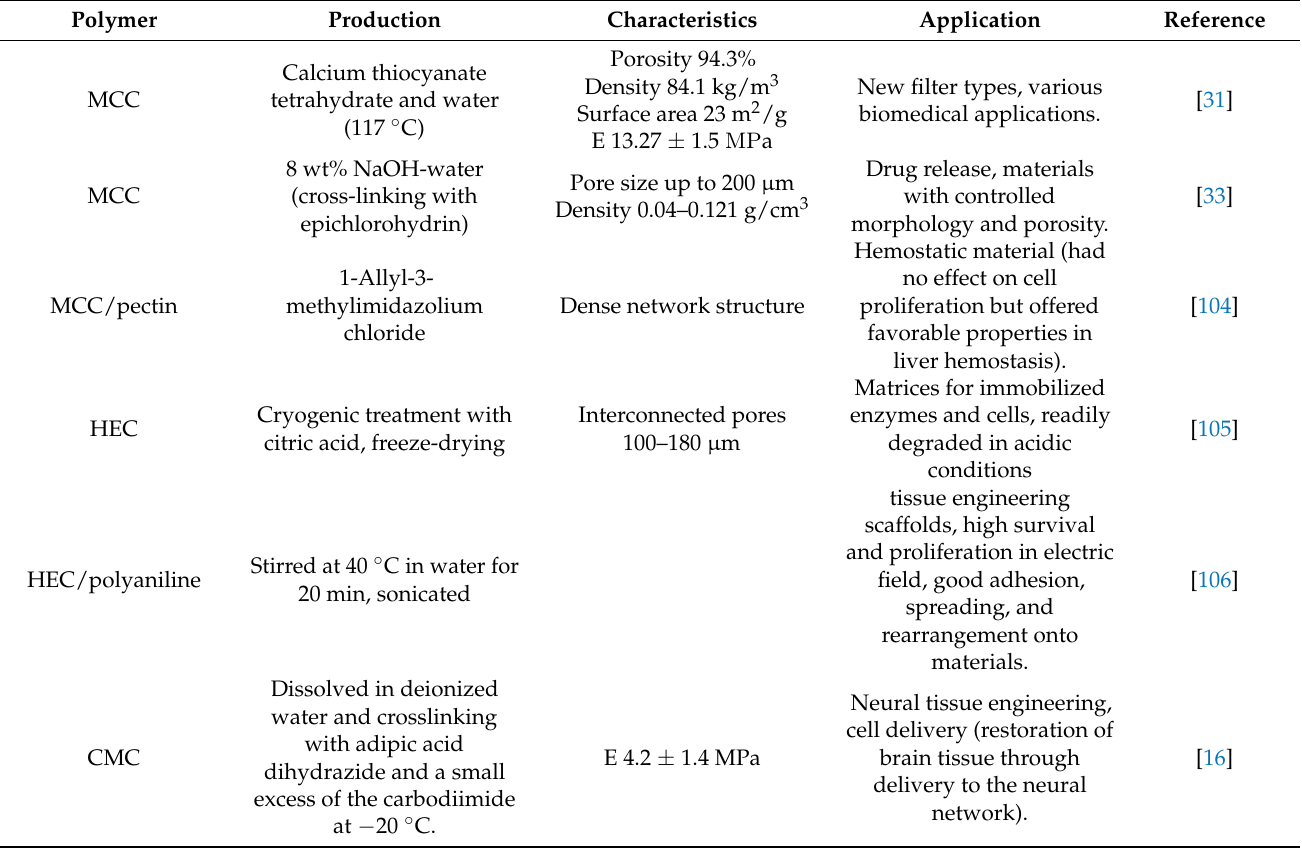
Table 2. Cellulose cryogels for biomedical